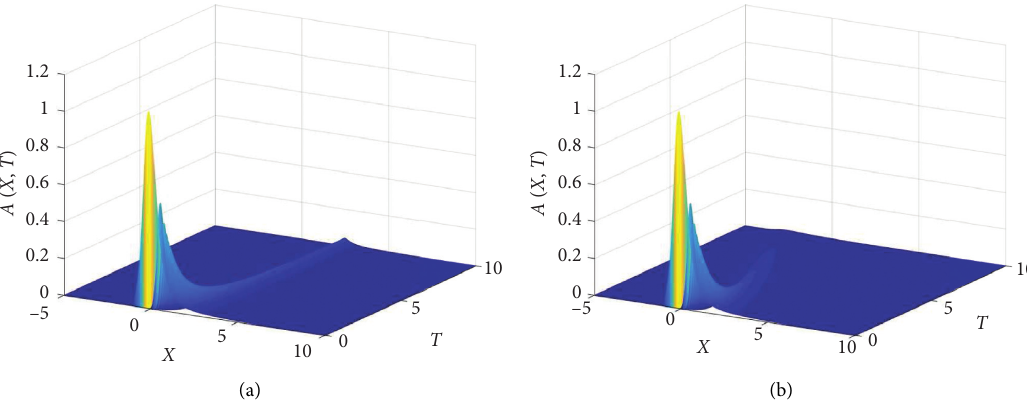
� − 1 ,a � − 20 , 􏽥 c � 0 , μ � 0 . 005; (b) α � 1 , a 2 1